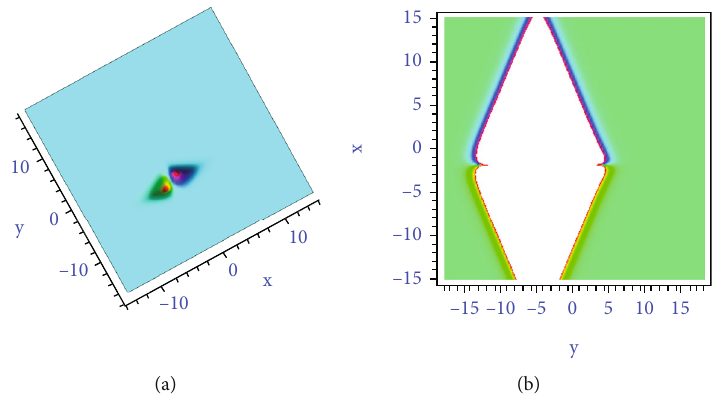
= β = σ = 1 , k = − 2 , δ 1 1 3 3